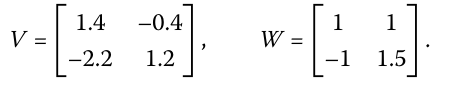
Figure 5 The change processes of synchronization errors with control (37)